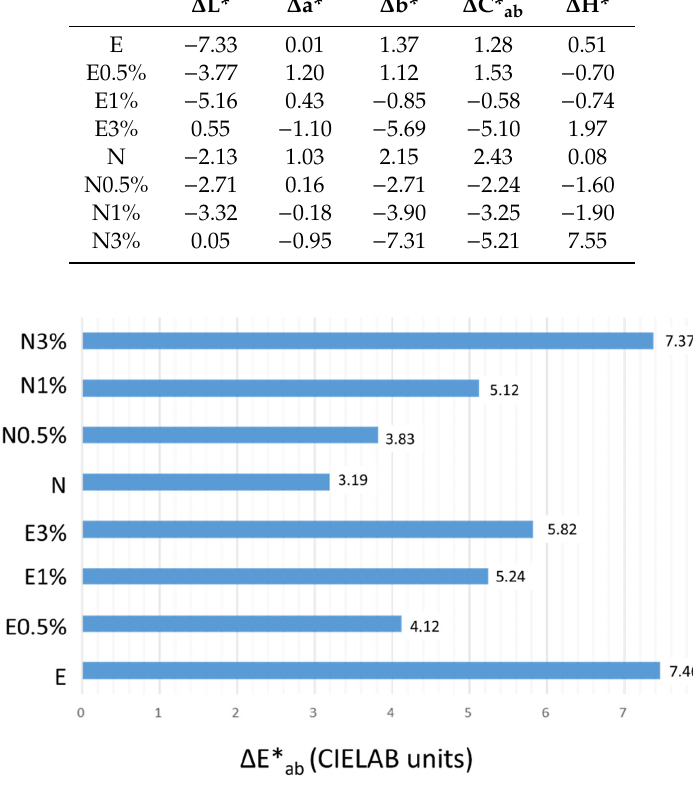
Table 2. Colorimetric variations ∆ L*, ∆ a*, ∆ b*, ∆ C* ab , and ∆ H* (CIELAB units) of the treated surfaces considering the color of the surface before to be treated as the reference, N = 60.